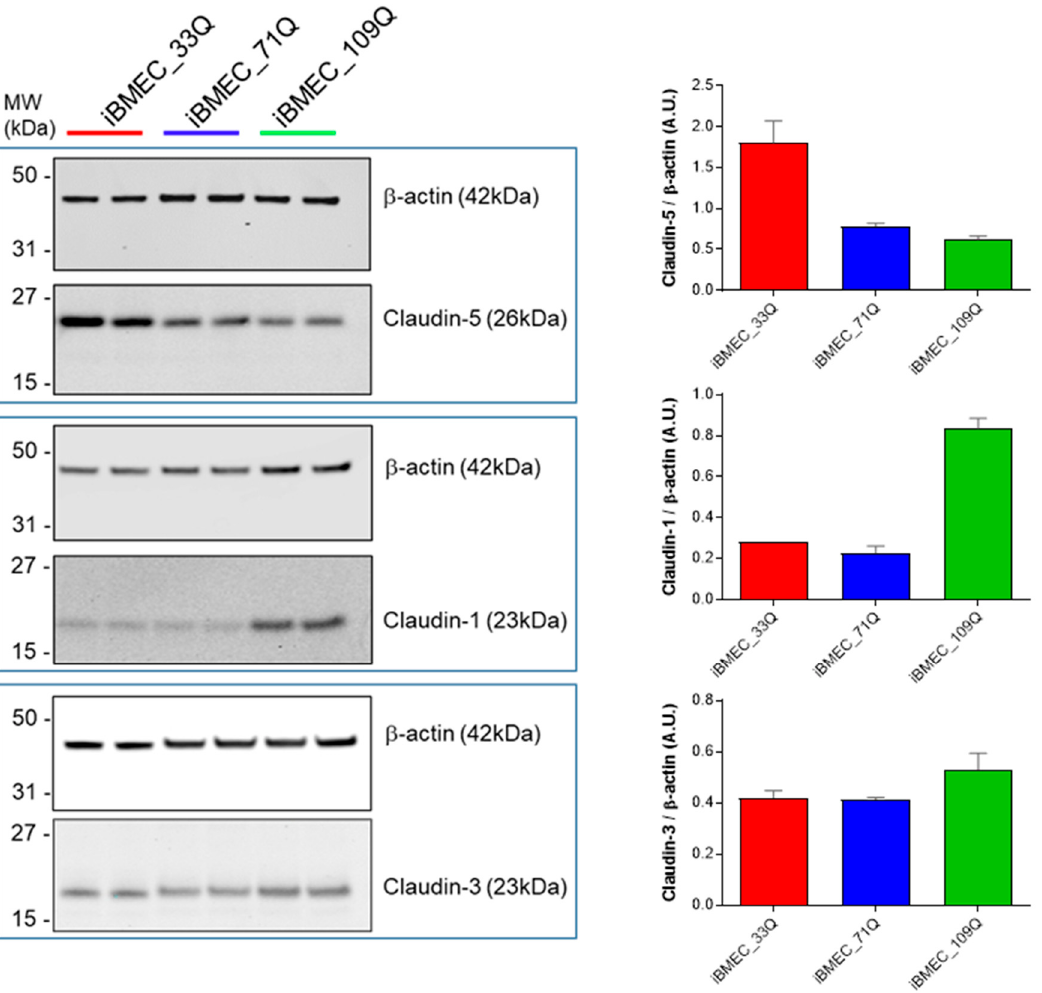
Figure 4. Claudins. Representative cropped Western blot confirming expression of Claudins 5, 1, and 3 in iBMECs. Β -actin was used as the loading control, and relative expressions are reported in the neighbouring bar charts.